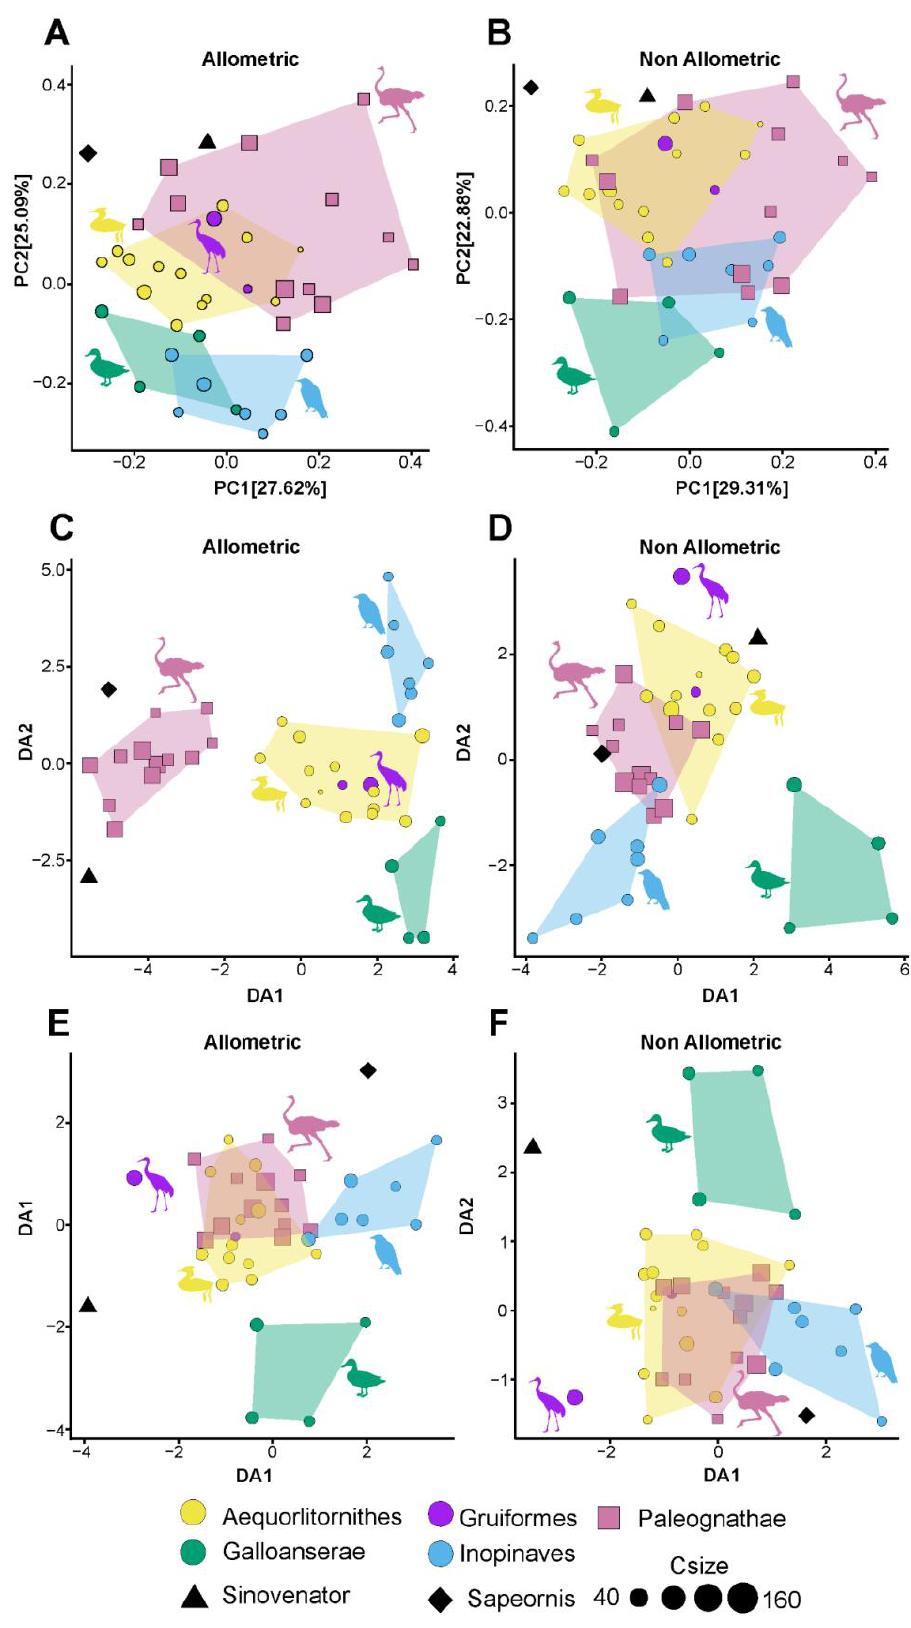
Figure 2. Differences between allometric and non-allometric morphospaces of the vomer (Dataset A) in palaeognath and neognath birds. (A) PCA (Principal Component Analysis) results of allometric data. (B) PCA results of non-allometric data. (C) DA (Discriminante Analysis) results of allometric data. (D)